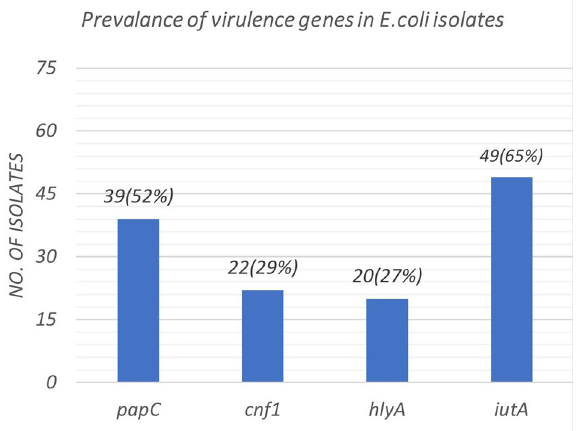
Figure 3. Prevalence of distribution of virulence genes among the 75 UPEC isolates.